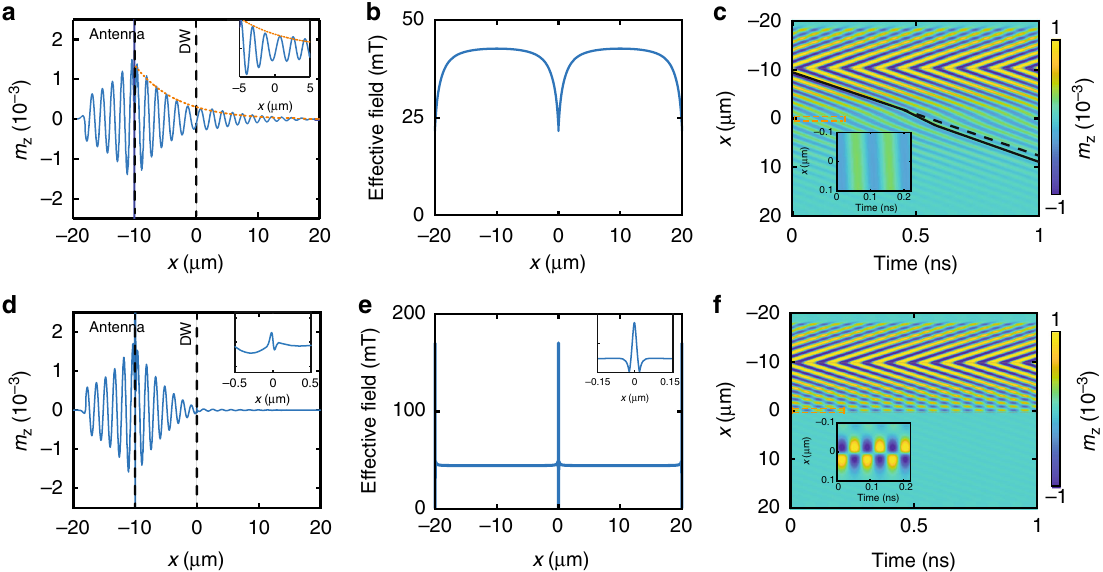
Fig. 4 Micromagnetic simulations of spin-wave transmission through single domain walls. Spin-wave transport through a broad 90° head-to-head domain wall ( a , c ) and a narrow 90° head-to-tail domain wall ( d , f ) at a frequency of 10.85 GHz. The panels show data for the steady excitation state, which is reached 9 ns after the sinusoidal magnetic fi eld is turned on. The effective magnetic fi elds of the two domain walls are plotted in b and e . The dashed line in a depicts the amplitude of propagating spin waves if no domain wall is present. The inset in f illustrates strong out-of-phase oscillations of two anti-nodes inside the head-to-tail domain wall